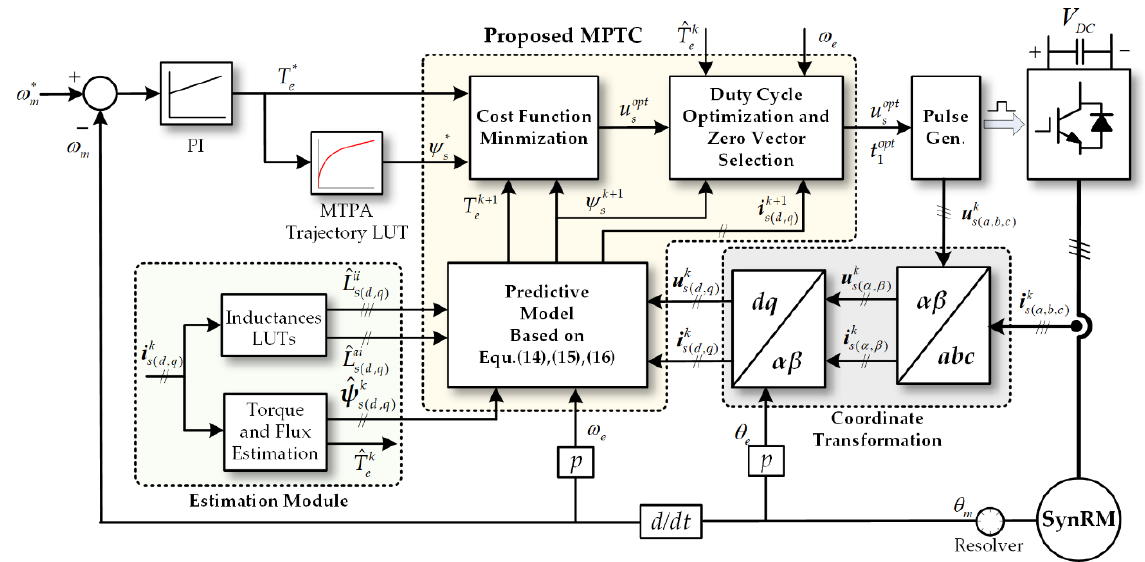
Figure 5. Control diagram of the proposed model predictive torque control (MPTC) method with duty cycle optimization and the MTPA trajectory. LUTs: look-up tables, PI: proportional–integral.